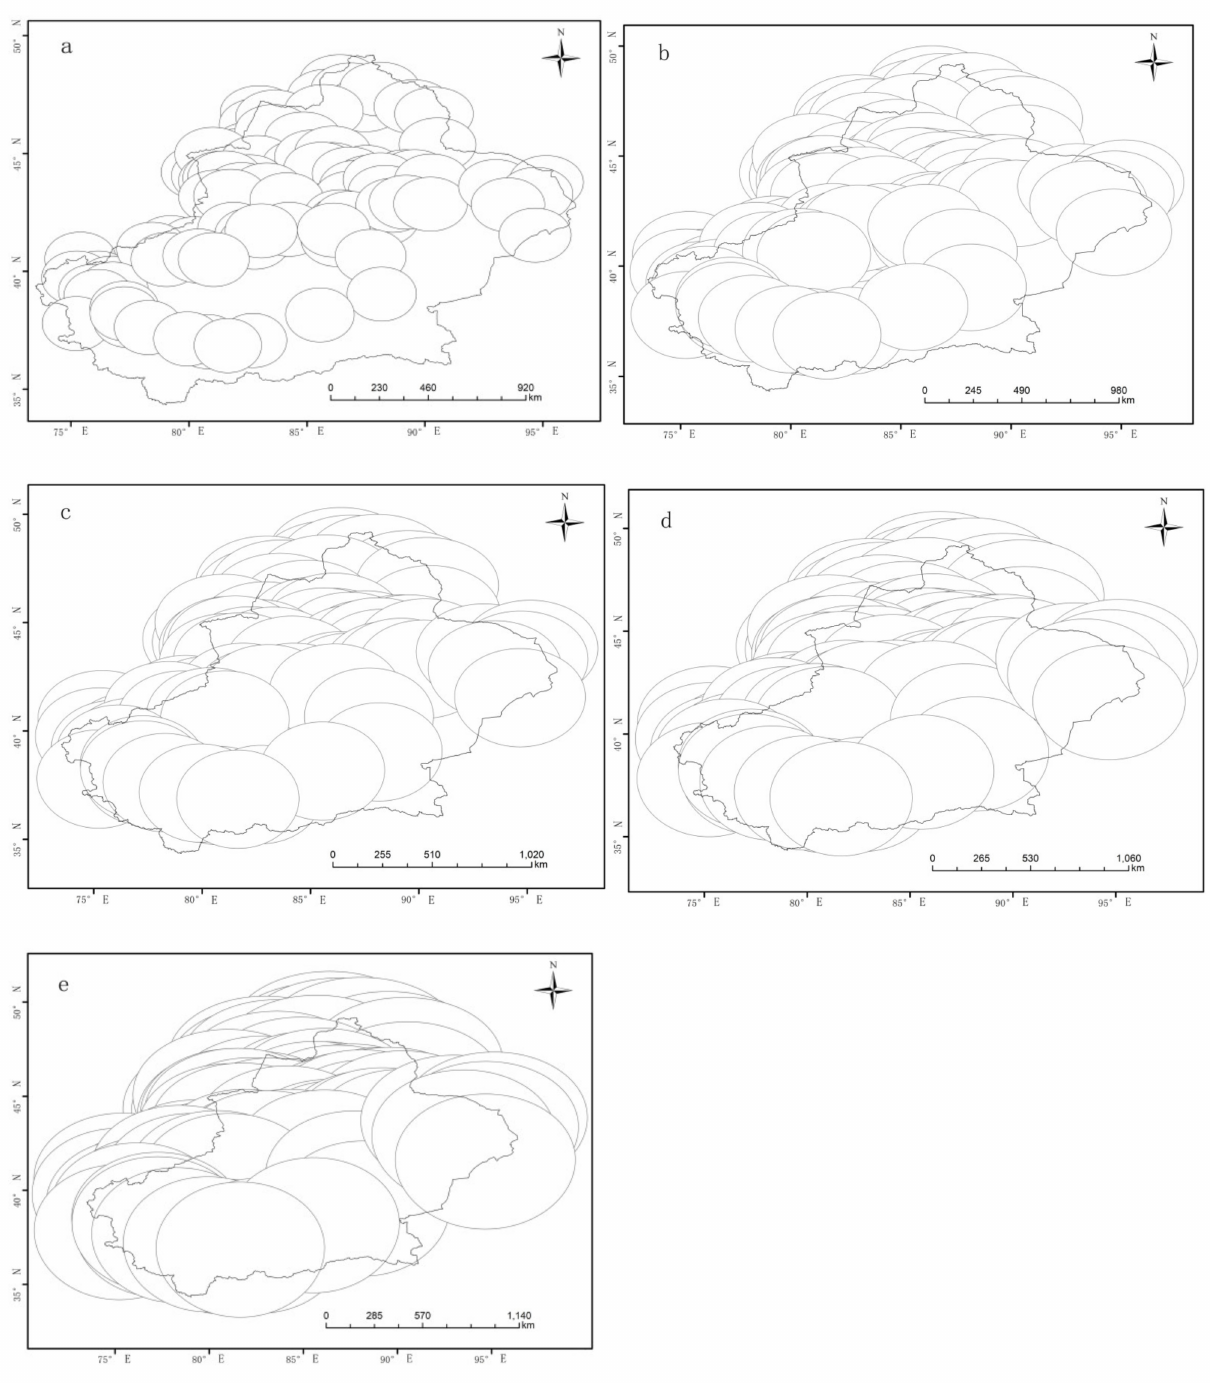
Figure 2. Weather station (89 stations) network coverage area schematic diagram in Xinjiang regionaa